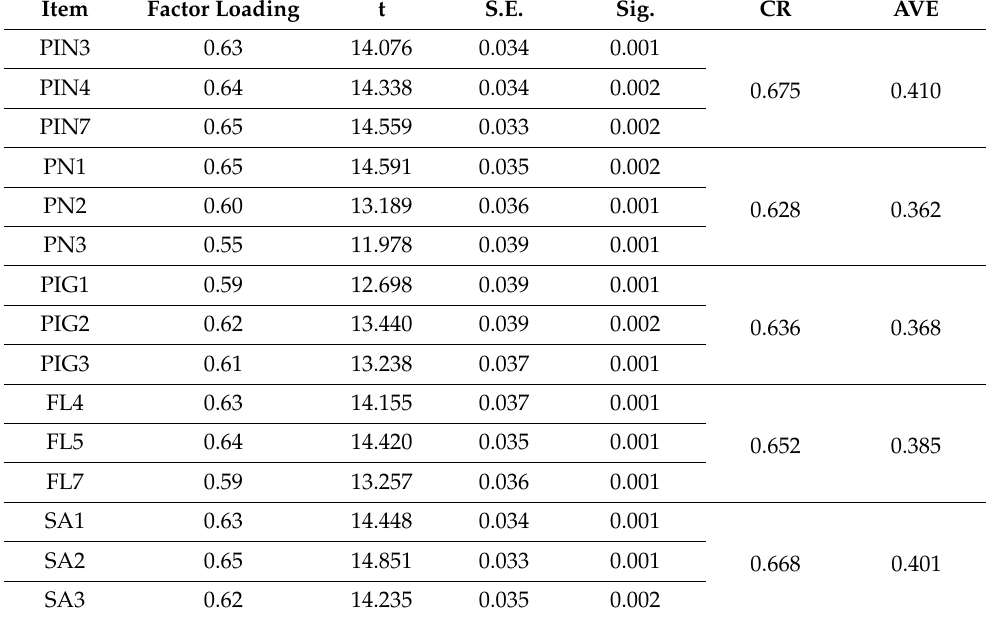
Table 8. Convergence validity